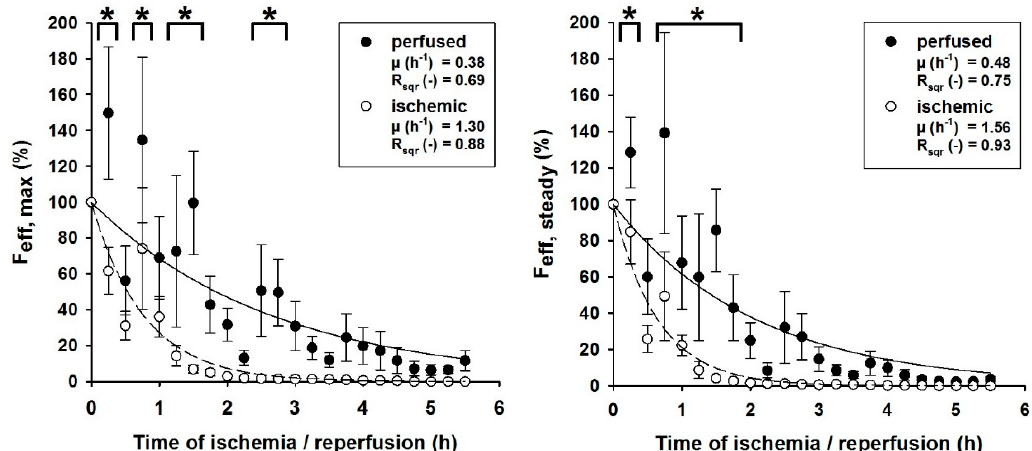
Figure 3. Normalized effective force per voltage of muscles undergoing hydrostatic EP ( ● ) and ischemia ( ○ ) at different points in time after harvest; ( left ) effective maximum force (F eff,max ) at different points in time; ( right ) effective steady-state force (F eff,steady ) at different points in time. Mathematical fit of the form F e ff = a · e − µ t ; µ: force decline rates; R sqr : coefficient of determination; error bars represent standard error of individual values recorded at the same time (n = 5); effective forces pooled under an asterisk ( * ) are statistically significantly different during the time of storage, indicating that EP is superior to ischemic storage during this time.